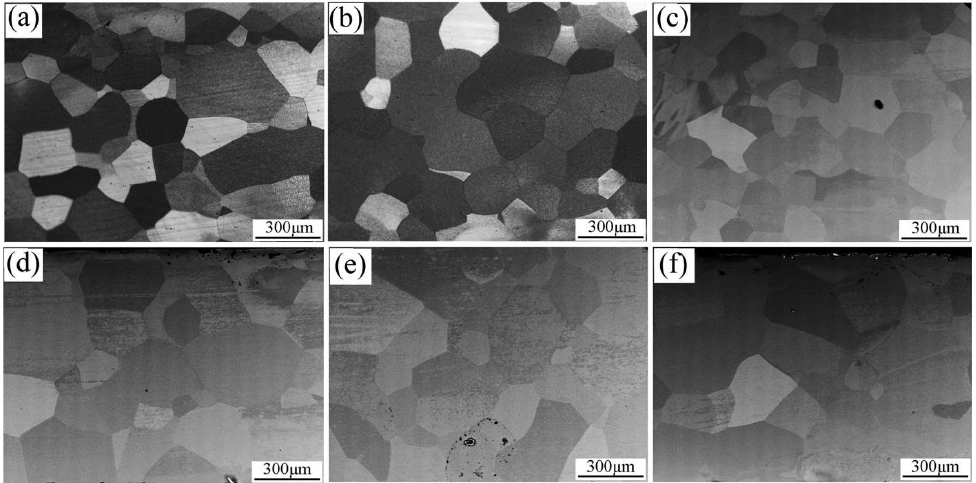
Figure 5. ECC image of 500 °C ( a ) CR-50%, V = 60 °C/min; ( b ) CR-50%, V = 100 °C/min; ( c ) CR-70%, V = 60 °C/min; ( d ) CR-70%, V = 100 °C/min; ( e ) CR-85%, V = 60 °C/min; ( f ) CR-85%, V = 100 °C/min.